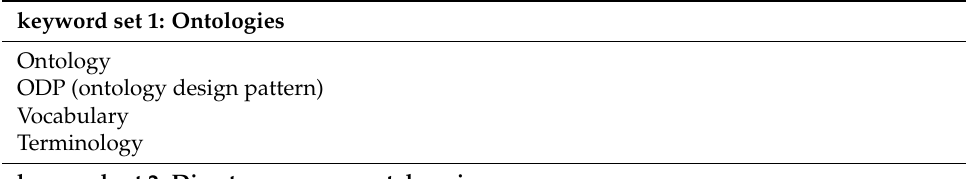
Table 1. Keyword Sets Ontologies in the Disaster Management